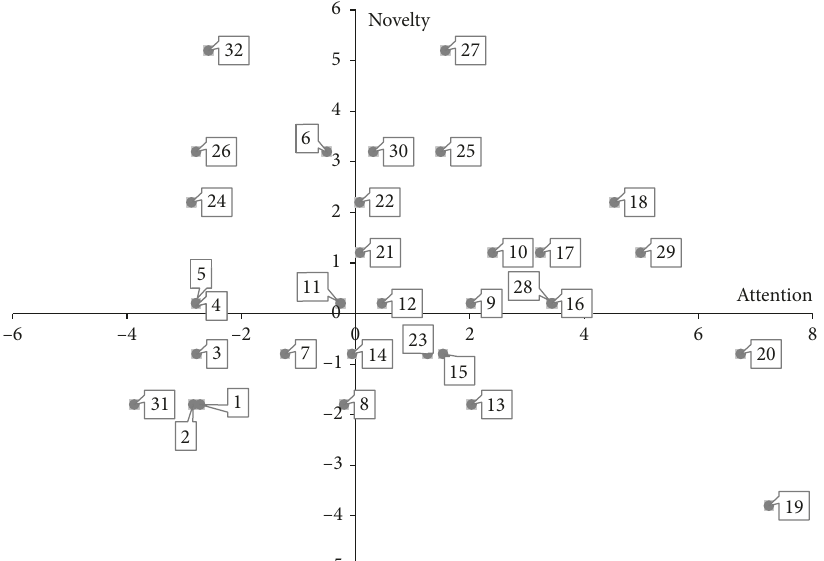
Figure 4: The strategic diagram of keyword clustering on UTD journals published by Chinese business school from